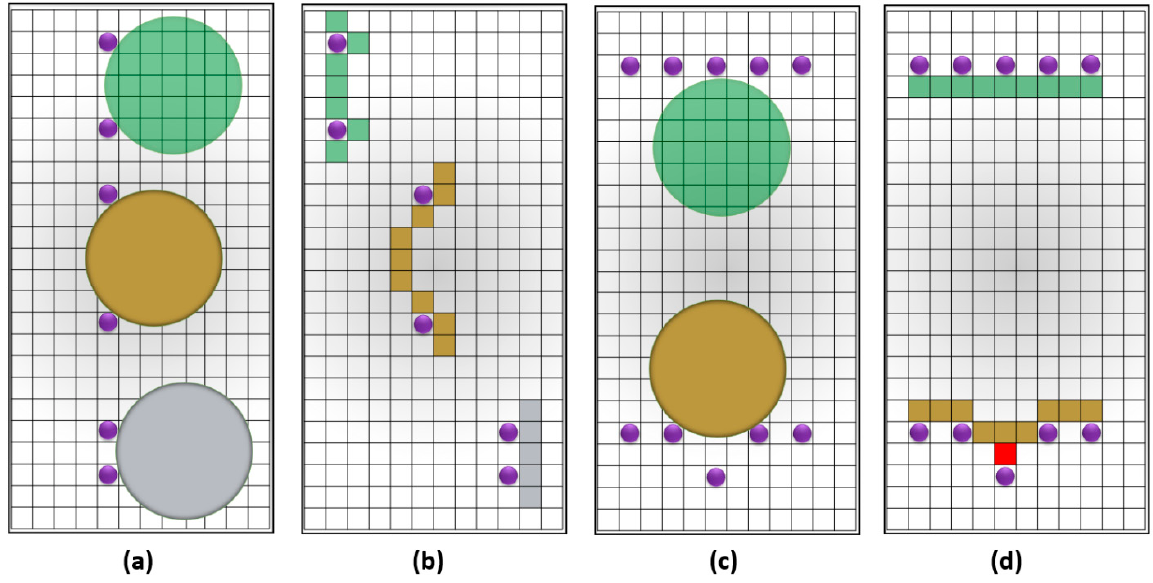
Figure 12. The random error in VDT measurement. ( a ) The same VDT detector colliding with points of different gaps; ( b ) the accessed area after collision; ( c ) the large VDT detector colliding with smooth and coarse points; ( d ) the missing area marked using red. In the figure, purple points refer to the points in a point cloud; big circles refer to VDT detectors; raster refers to a data storage architecture, the matrix.